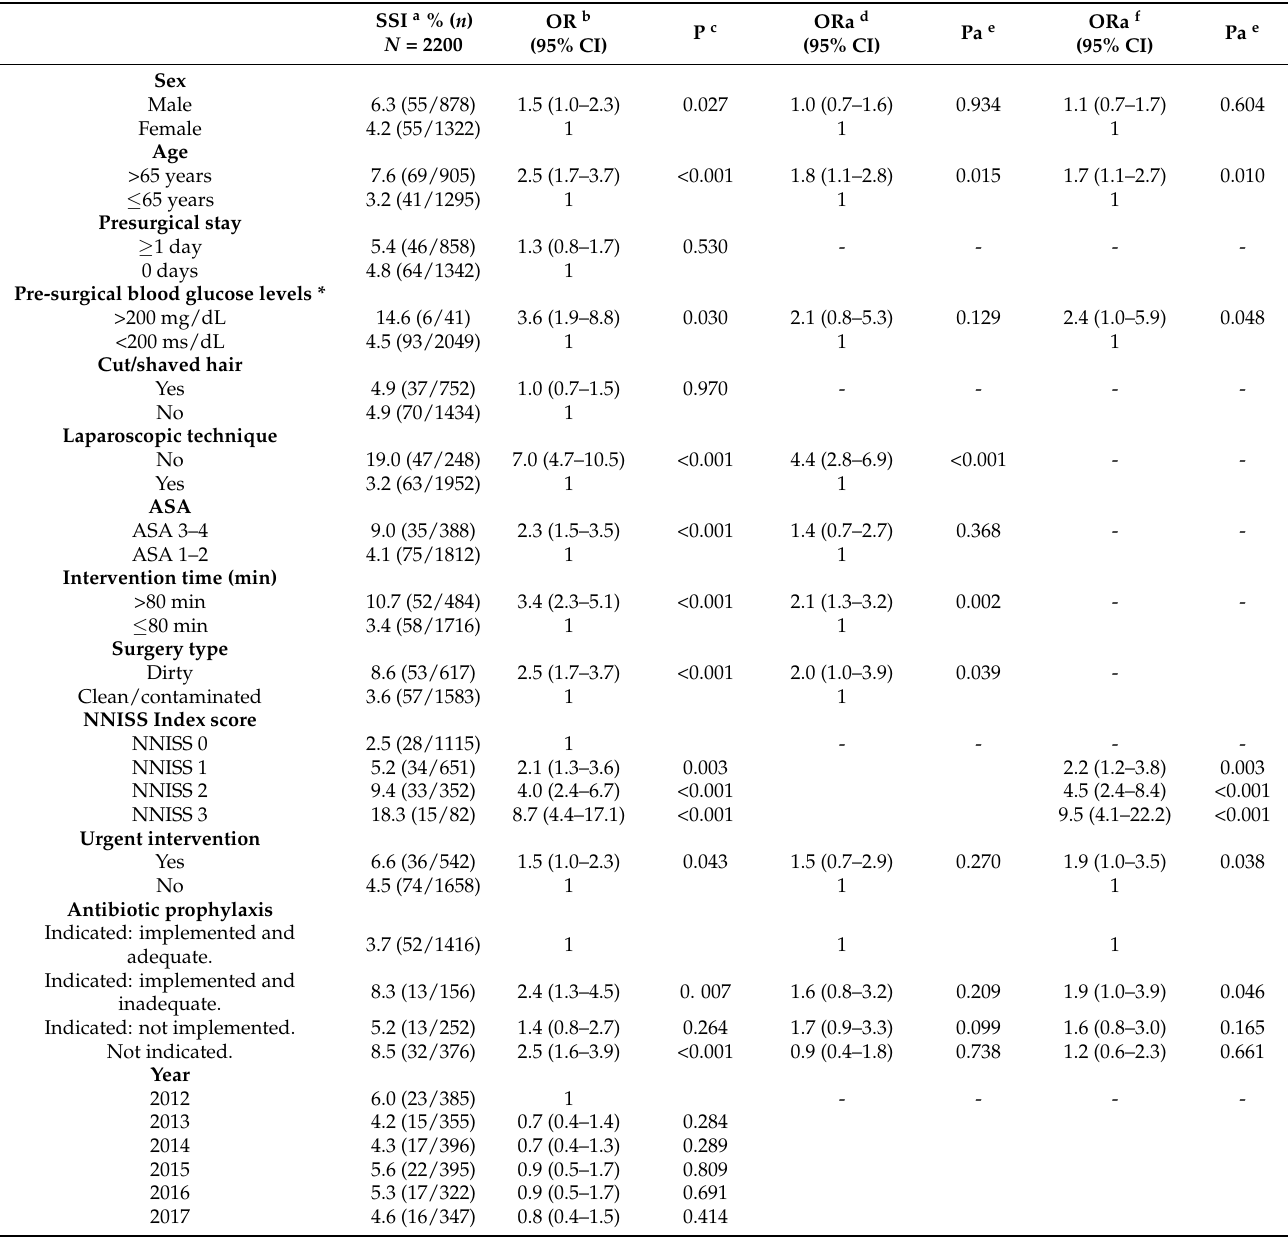
Table 1. Factors associated with surgical site infection after